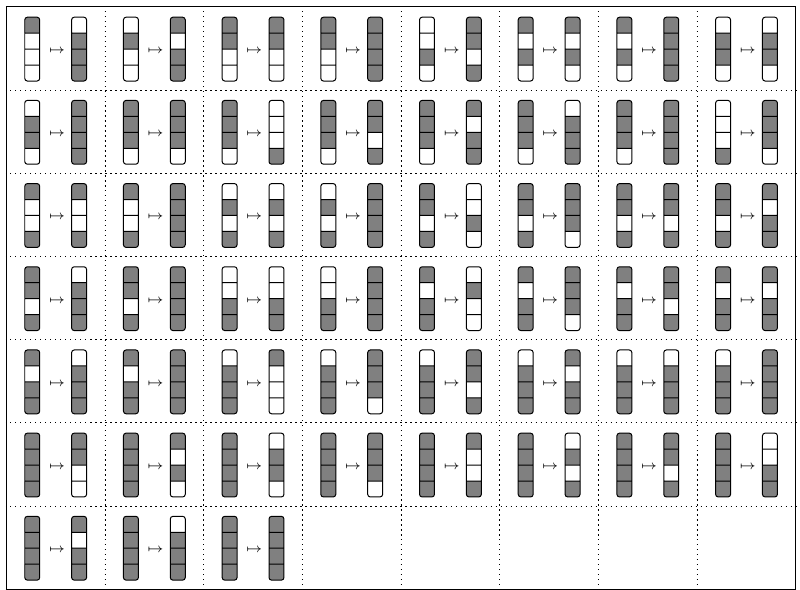
Figure 4: The Column-wise Active State Transitions for Class I Matrices